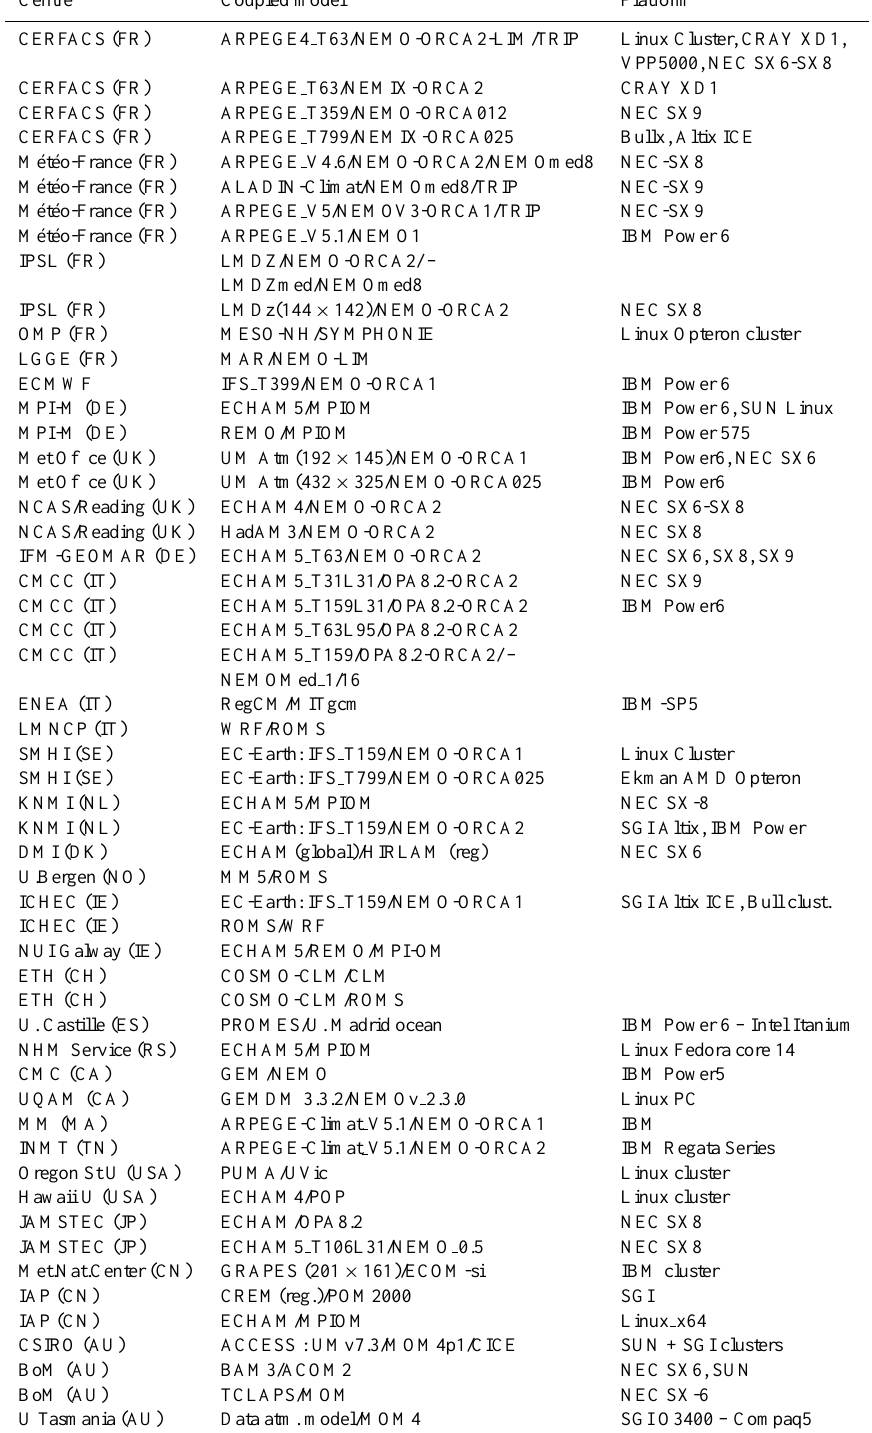
Table A1. Use of OASIS3: centres, coupled models and computing